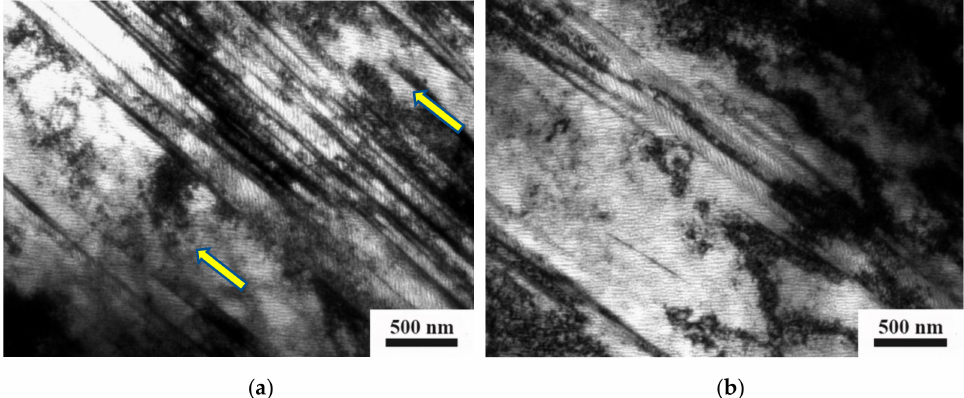
Figure 1. TEM images (bright field) of the TWIP steel subjected to a single ECAP pass. Regions with fine-scaled twins ( a ) and wide deformation bands annotated by arrows ( b ) are shown.